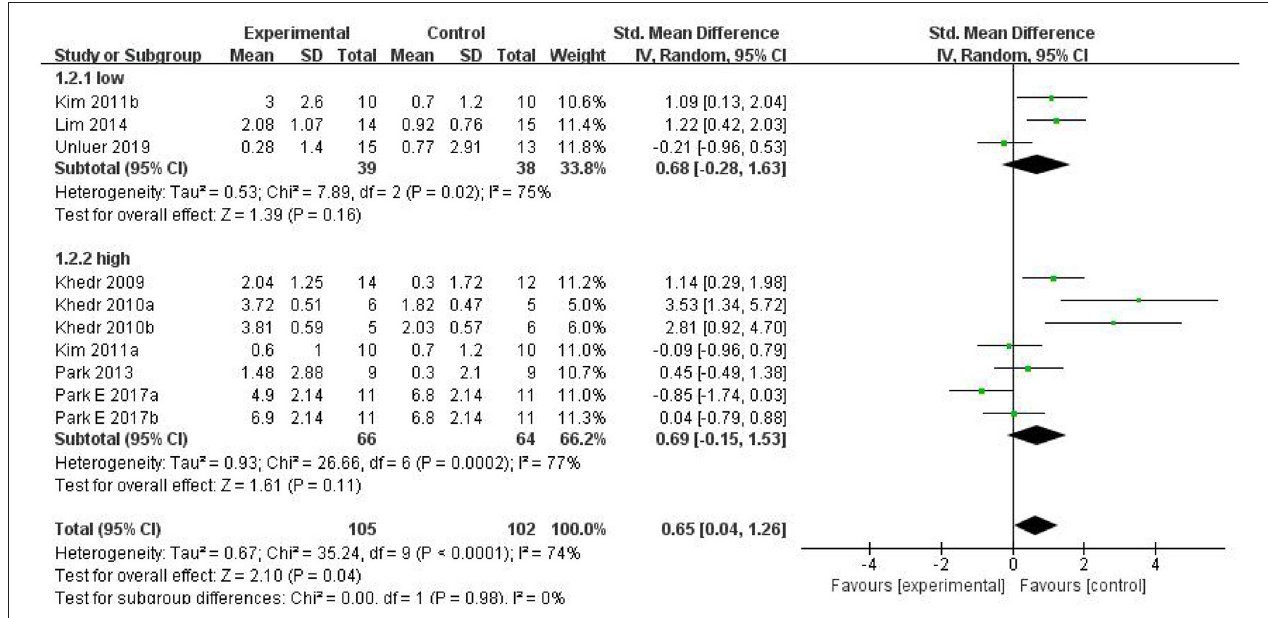
FIGURE 5 | Subgroup analysis of the effects of rTMS for swallowing function